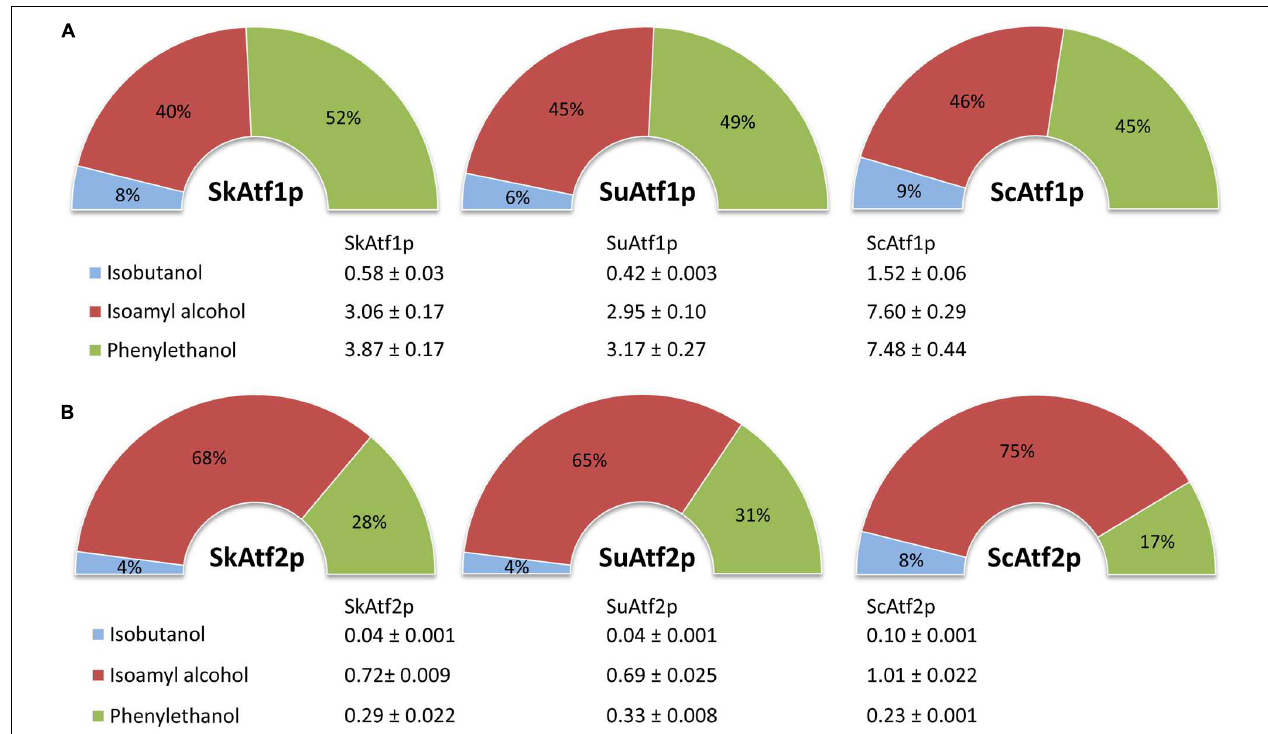
FIGURE 5 | The relative alcohol acetyltransferase activities of the Atf1 (A) and Atf2 (B) enzymes expressed as a percentage distributed among the total enzymatic activity of the measured substrates. The presented values [nmol · min − 1 (mg protein) − 1 ] are averages and mean deviations of three replicates. The activities of the different Atf1 and Atf2 enzymes were measured in the cell extracts of the S. cerevisiae strain with atf1 atf2 iah1 deletion at a concentration of 60 mM for isobutanol, 100 mM for isoamyl alcohol and 30 mM for 2-phenylethanol.